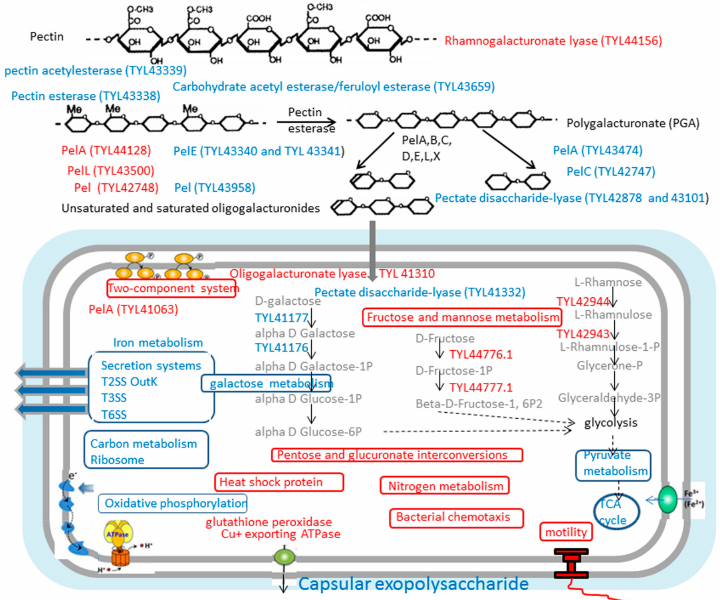
Figure3. Overviewofpathwaysandfunctionsa ff ectedbythevegetablestalkinMSMmediumcompared to LB medium. Functions marked in red are upregulated while those in blue are